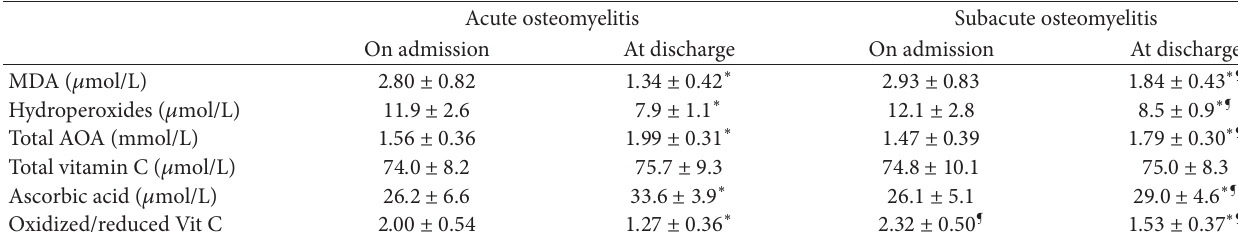
Table 3: Oxidative stress markers and vitamin C status in acute and subacute bacterial osteomyelitis. Acute